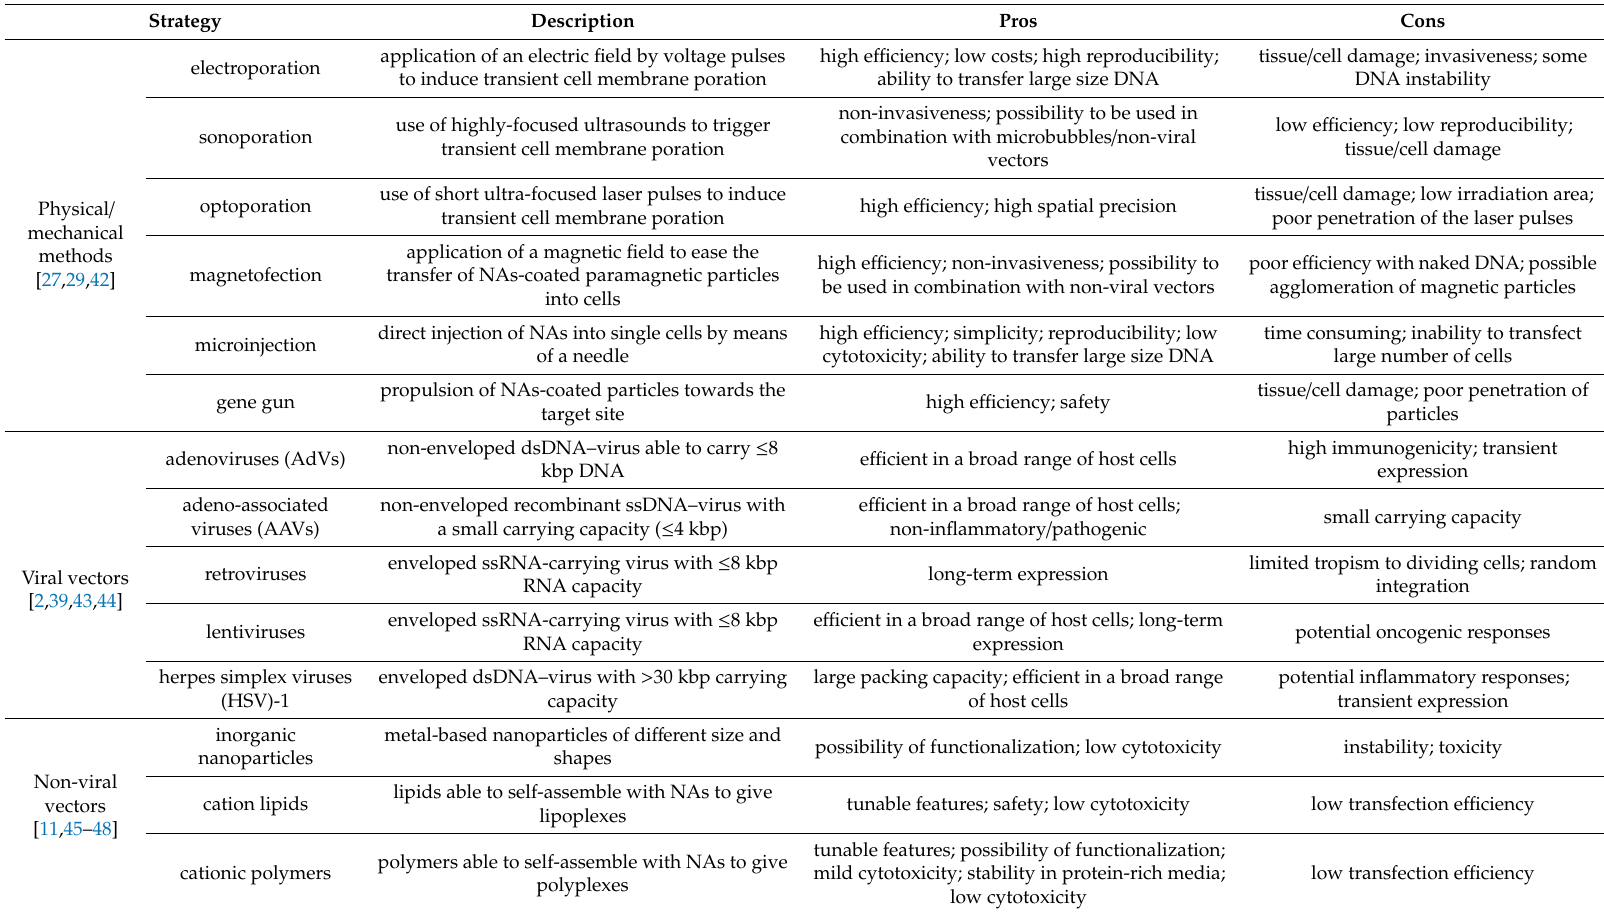
Table 2. Overview of the di ff erent transfection technologies for gene delivery